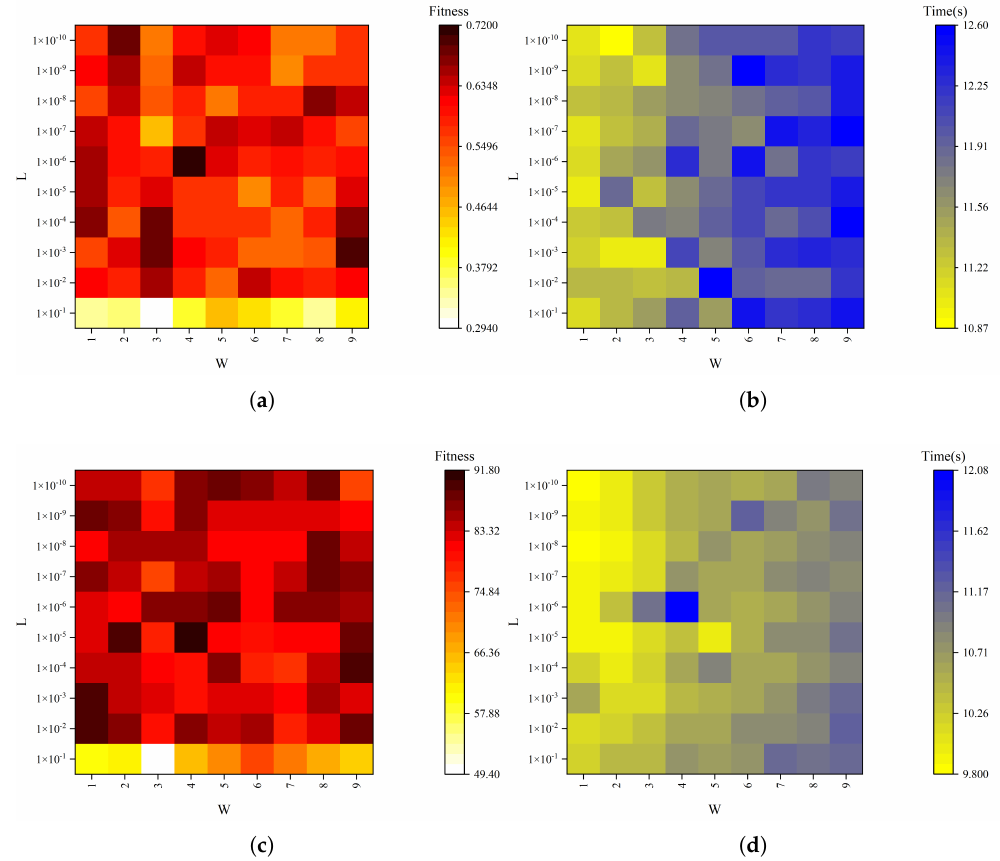
Figure 9. The fitness and time of the Ellipsoid function and the Rastrigin function change with coefficients of DBC. ( a ) Fitness of the Ellipsoid function. ( b ) Time of the Ellipsoid function. ( c ) Fitness of the Rastrigin function. ( d ) Time of the Rastrigin